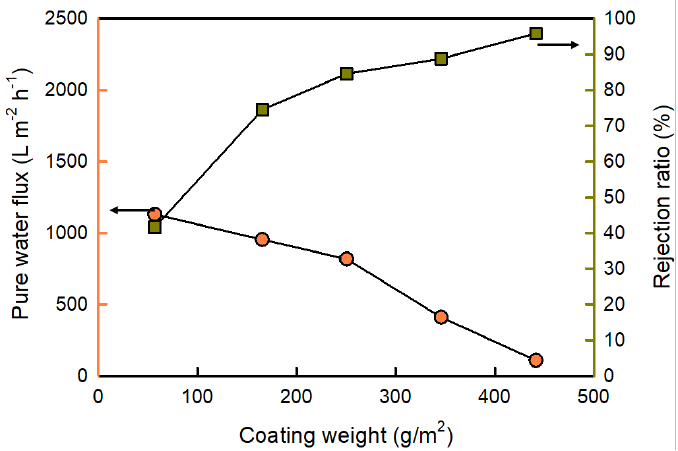
Figure 5. Effects of coating weight on the pure water flux and rejection ratio of the composite membrane.